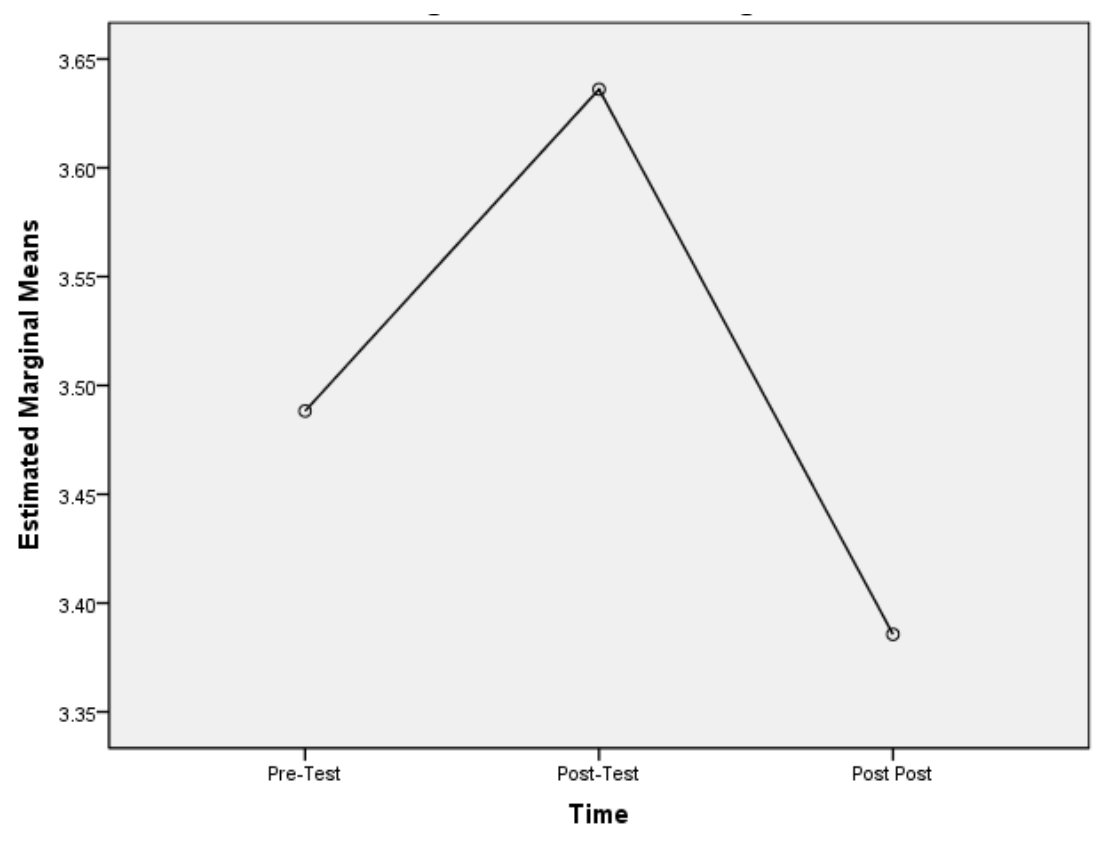
Mean scores of the pre-, post-, and 8-month post-test data collection intervals, depicting a decrease in knowledge over time after participation in the PEAK